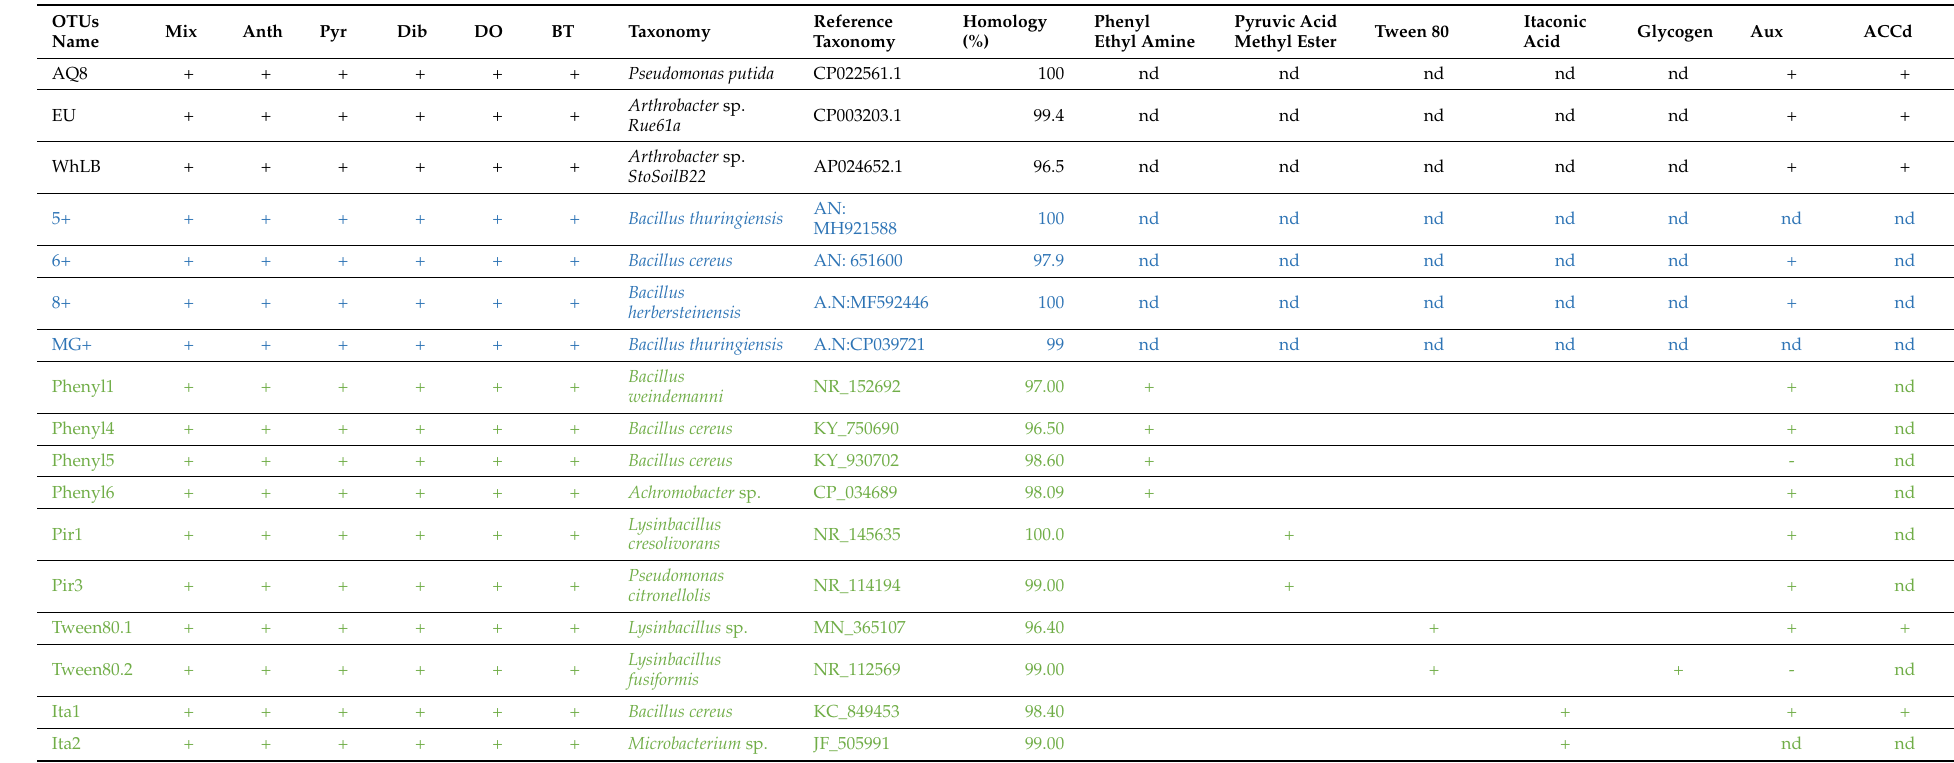
Table 2. Specialist bacterial isolates capable of utilising different carbon sources (AQ8, EU, WhLB); Gram-positive isolates capable of utilising the different carbon sources (5+, 6+, 8+, MG+); Generalist bacterial isolates isolated using the Eco-plates TM and capable of utilising different carbon sources (Phenyl1, Phenyl4, Phenyl5, Phenyl6, Pir1, Pir3, Tween80.1, Tween80.2, Ita1,Ita2). Mix: mixture of diesel oil, bitumen, anthracene, pyrene, dibenzothiophene; Anth: Anthracene; Pyr: Pyrene; Dib: dibenzothiophene; DO: diesel oil; BT: bitumen; Aux: positive for indole-3-acetic acid (IAA) production; ACCd: positive for 1-aminocyclopropane-1-carboxylic acid (ACC) deaminase activity. For each strain (+) indicates that the activity was detected, (nd) that the activity was not